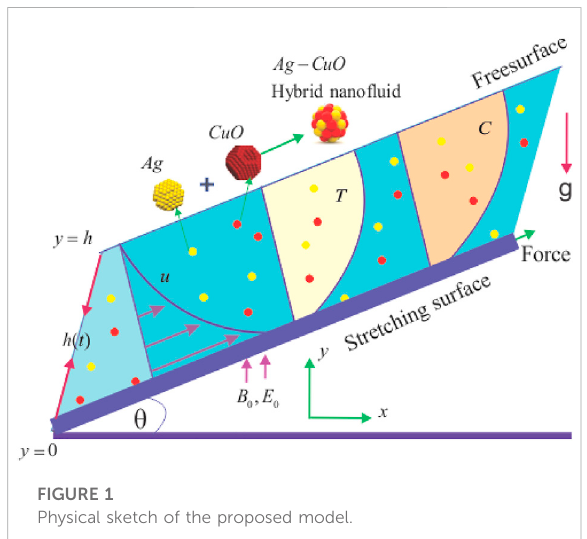
FIGURE 1 Physical sketch of the proposed